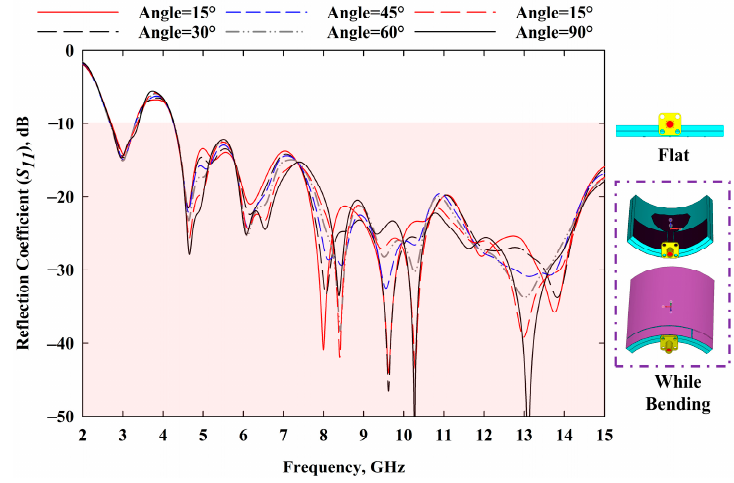
Figure 12. MBRU antenna bending analysis (at 4V varactor tuning condition).